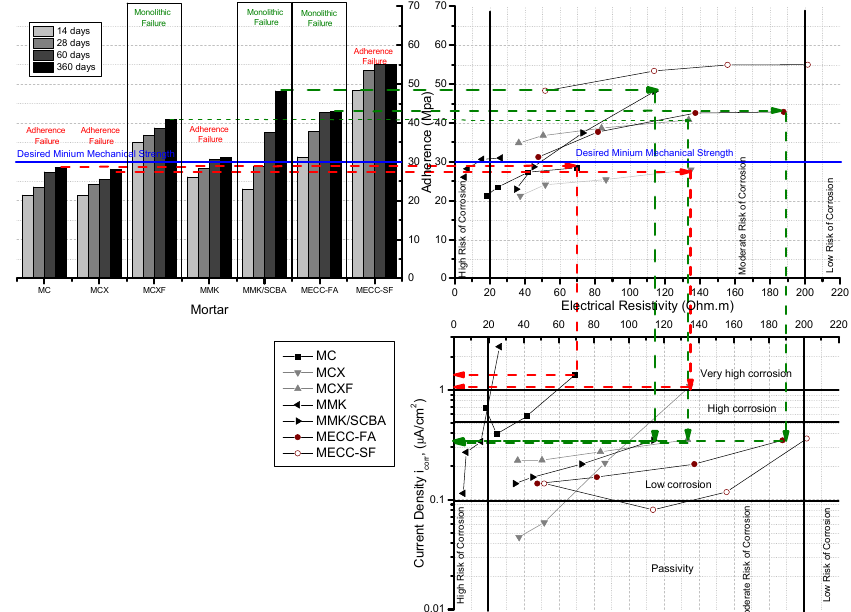
Figure 7. Relation between electrical resistivity, adherence, and corrosion current density of AISI 1018 CS in mortars exposed in 3.5 wt % NaCl solution.